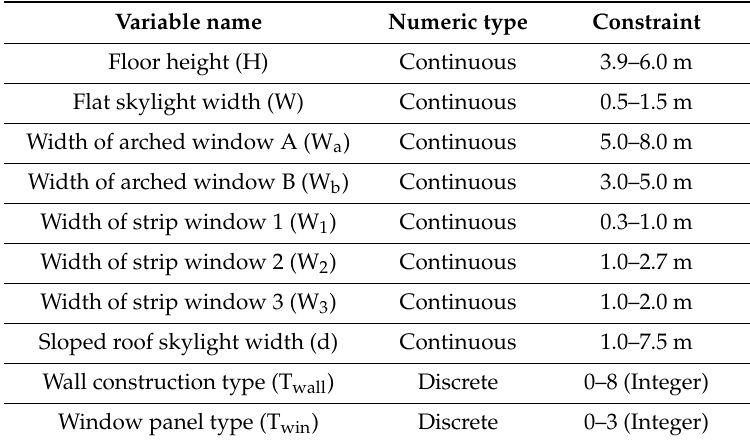
Table 1. Decision variables and